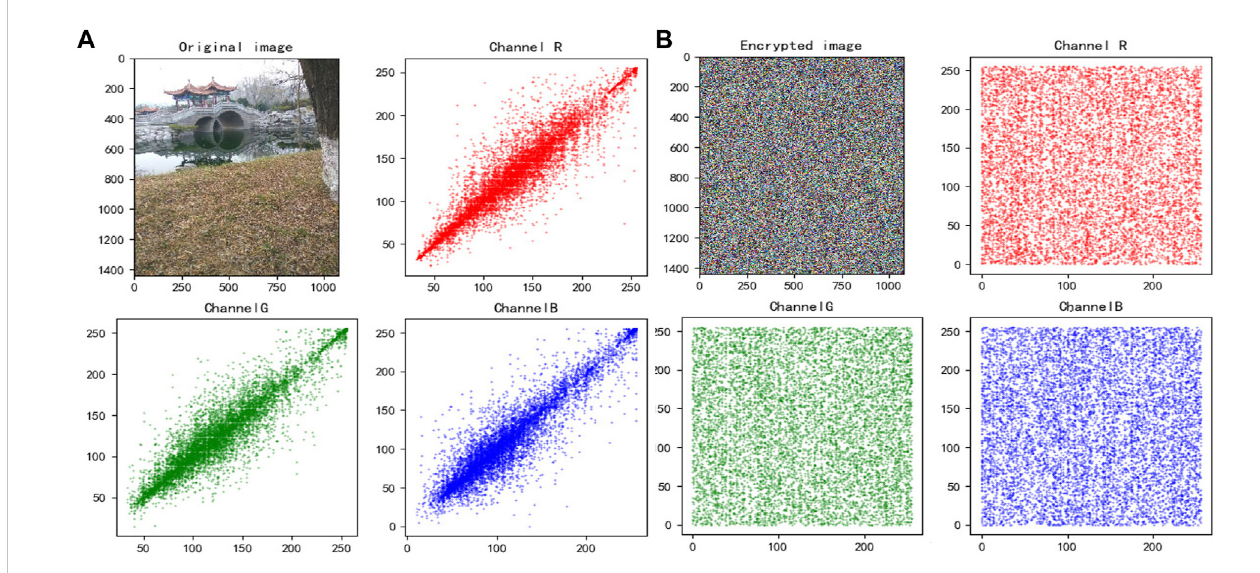
FIGURE 6 Bridge ’ s correction: (A) is original image ’ s correction, and (B) is encrypted image ’ s correction.